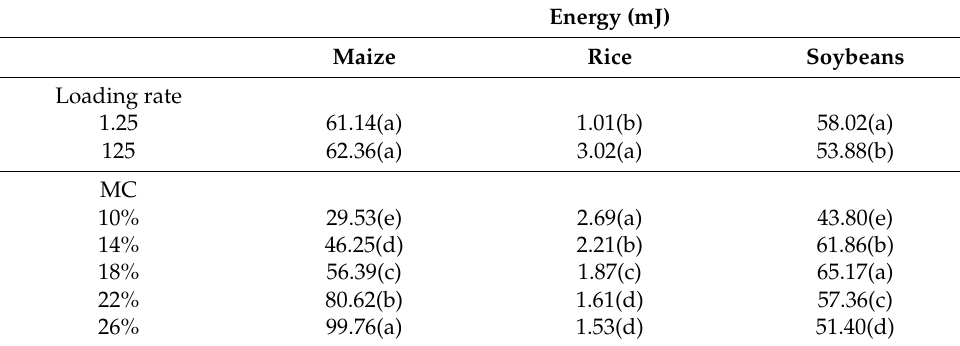
Figure 13. The dependence between moisture content and energy needed for single grain compression; ( a ) maize, ( b ) rice, ( c ) soybeans. sion; ( a ) maize, ( b ) rice, ( c ) soybeans. Table 5. The means comparison of energy needed to induce breakage at different moisture contents and loading